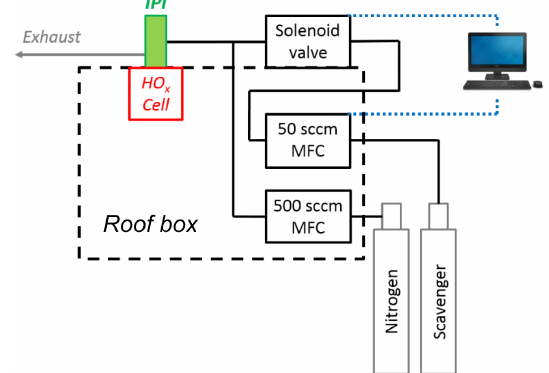
Figure 2. Diagram of the gas flows involved in IPI scavenger in- jection (not to scale). The two mass flow controllers (MFCs) are housed in the roof box, where the scavenger MFC (0–50sccm) and injection valve (in a weatherproof housing on top of the roof box) are controlled using the main FAGE PC situated in the container